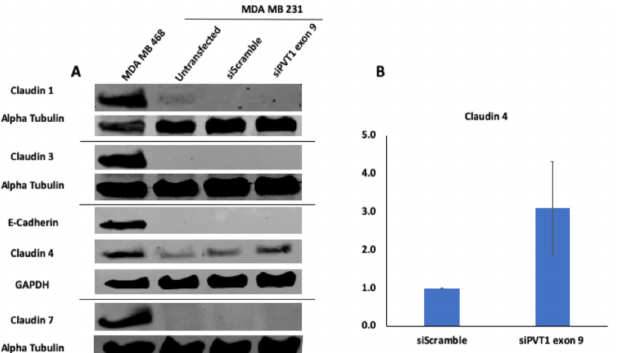
Figure 6. SiRNA targeting of PVT1 exon 9 induces claudin 4 protein re-expression in MDA MB 231 CL TNBC cells. ( A ) MDA MB 231 CL TNBC cells were transfected with PVT1 exon 9 specific siRNAs (siPVT1 exon 9) for 24 h. Western blotting was performed using specific antibodies against claudin